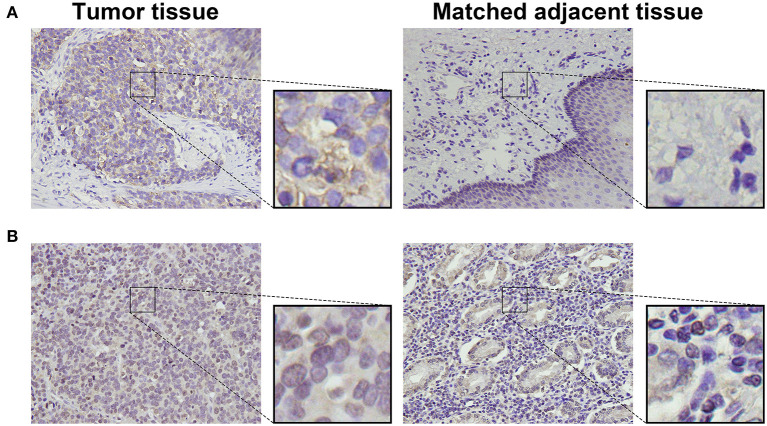
Representative images from IHC analyses of (A). CD155 expression and (B). TIGIT expression in PSCCE tissue sections of different stages (original magnification ×400).